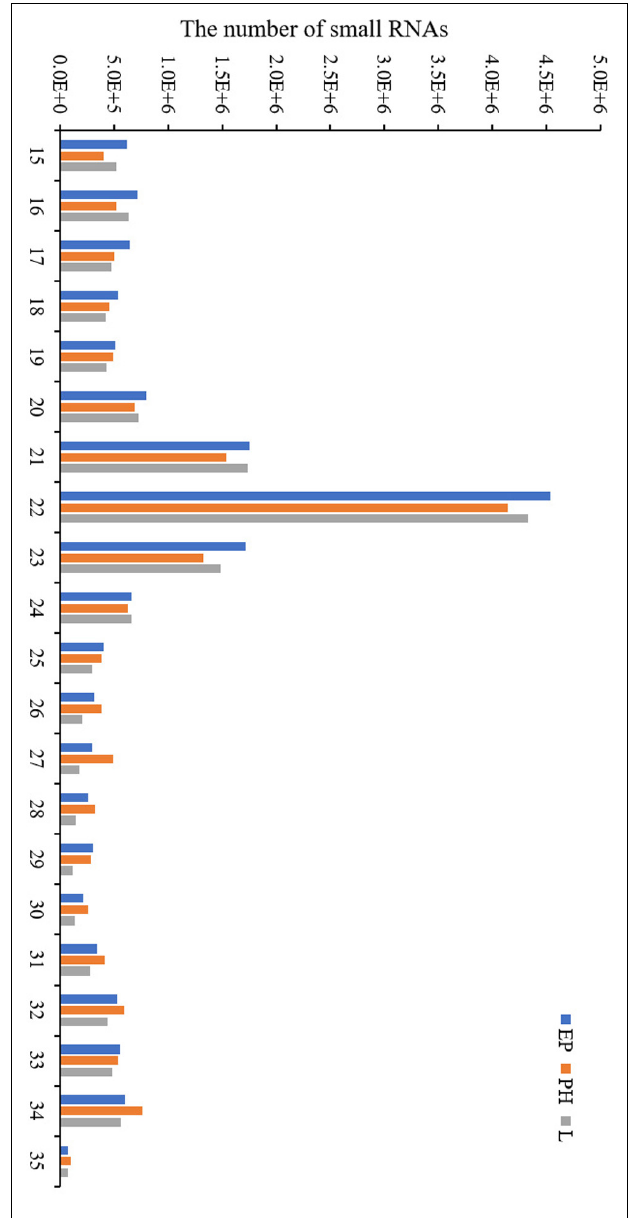
FIGURE 1 | Length distribution of the small RNA obtained by high-throughput sequencing in the three